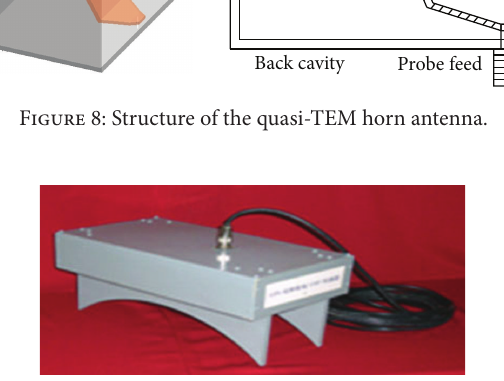
Figure 9: Physical map of the microstrip patch antenna.